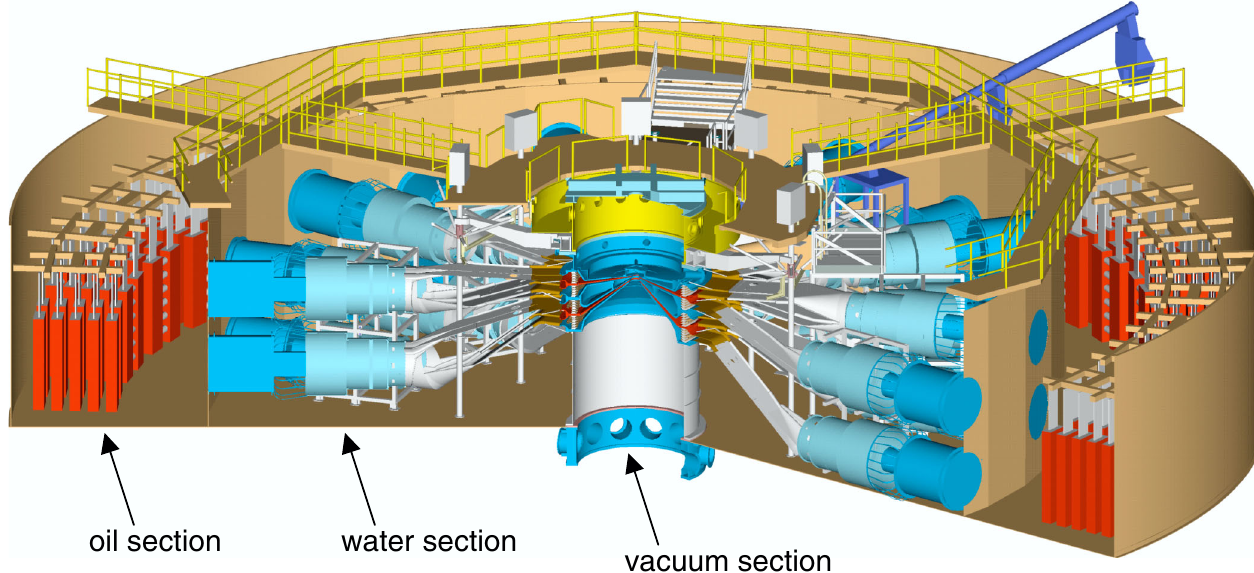
FIG. 1. (Color) Cross-sectional view of the Z pulsed-power accelerator [1–10]. The outer diameter of the accelerator was 33